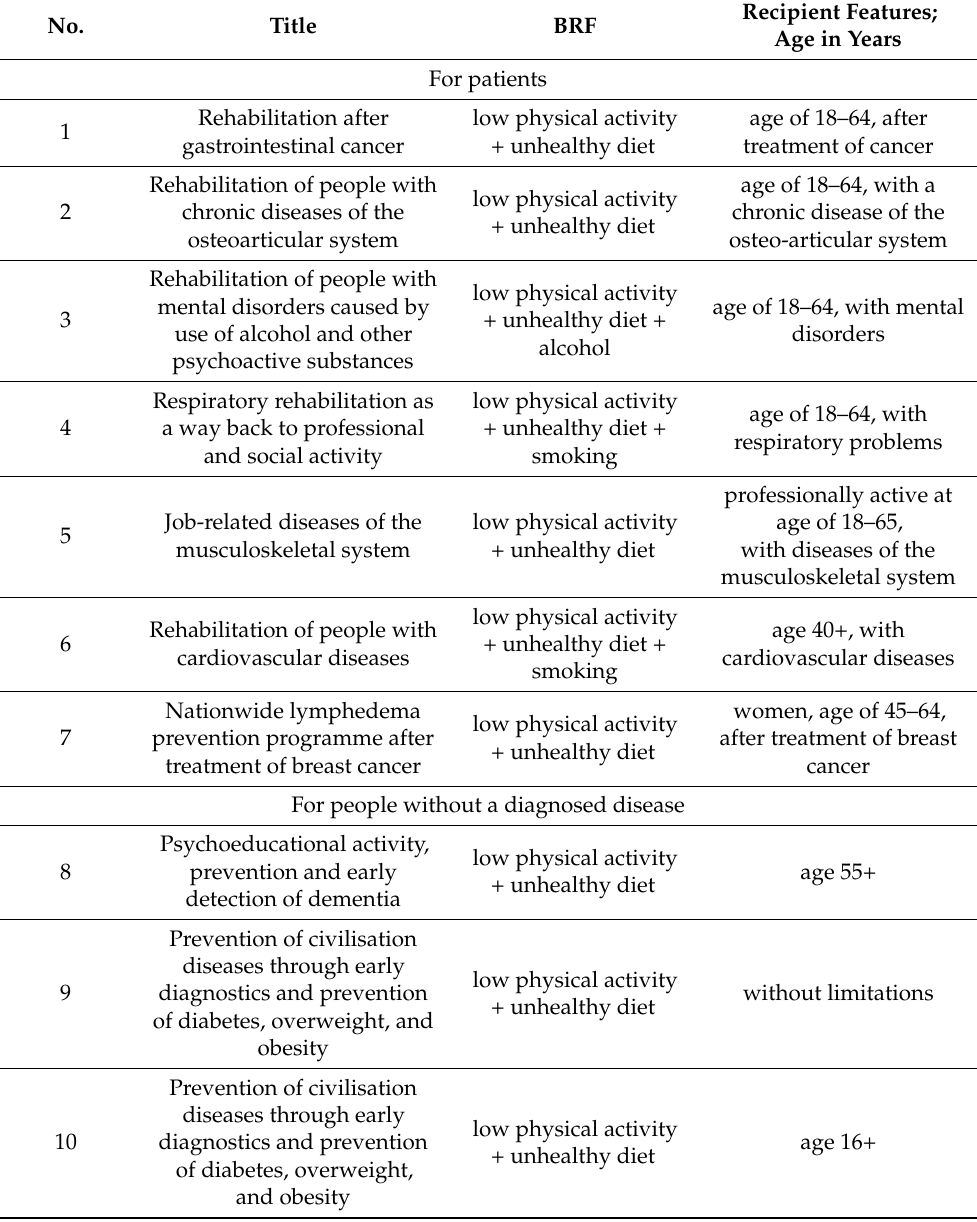
Table 4. Health programmes that acknowledge intervention in the scope of several behavioural risk factors (BRF), submitted by Polish local governments for the assessment of AOTMiT in 2018. Recipient Features; No. Title BRF Age in Years For